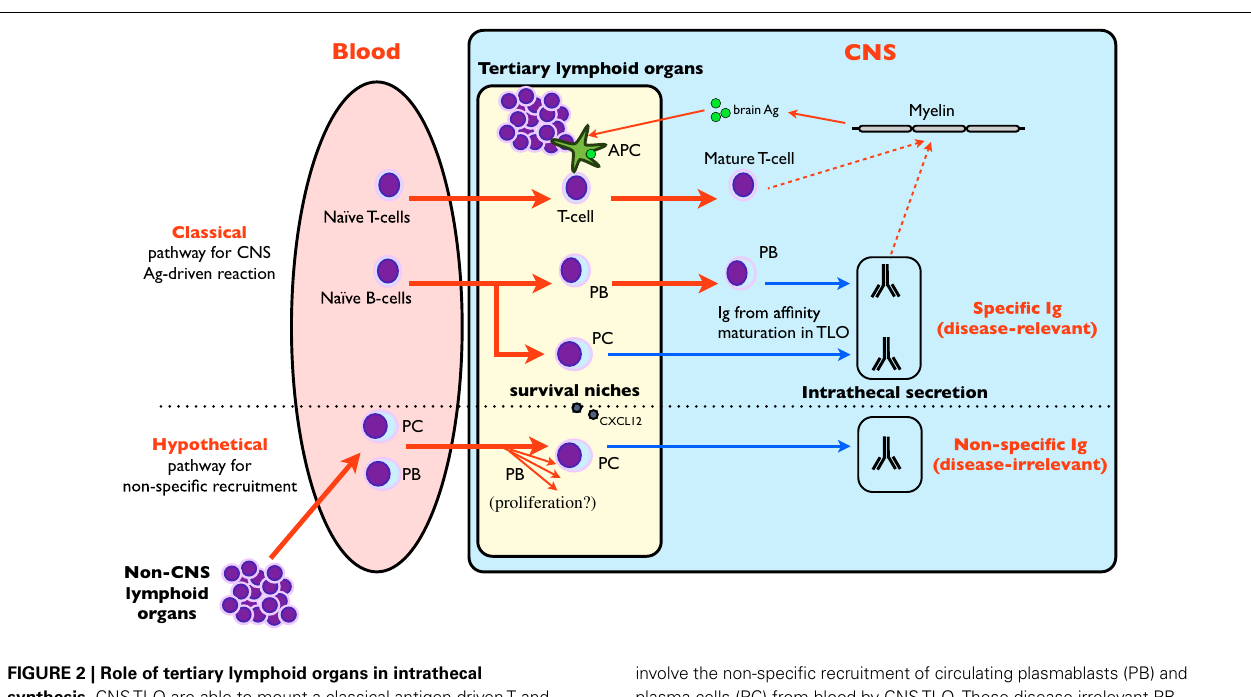
FIGURE 2 | Role of tertiary lymphoid organs in intrathecal synthesis . CNSTLO are able to mount a classical antigen-drivenT and B-cell clonal response that is responsible for intrathecal synthesis against brain-borne (and possibly disease-relevant) antigens (1, 46–48) (upper part of figure). A hypothetical pathway (lower part of figure) may